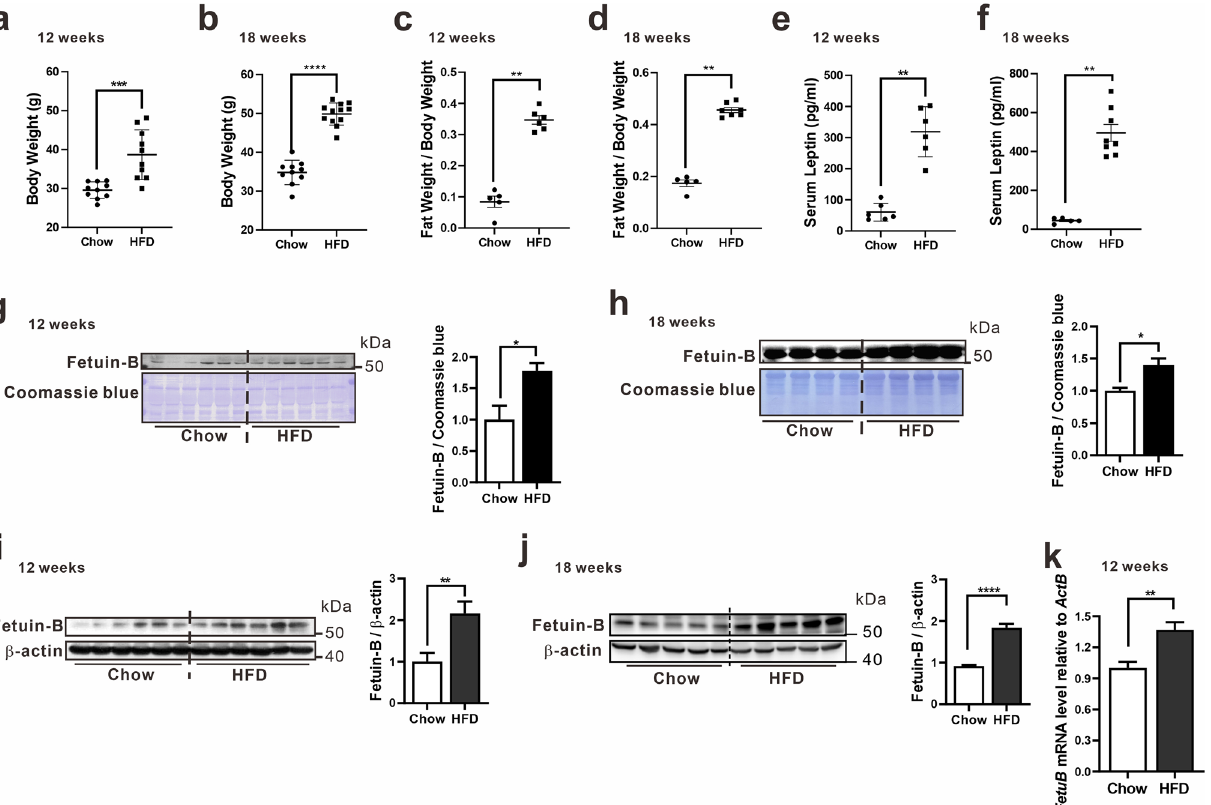
Figure 2. Expression of Fetuin B in HFD-induced obese mice. Body weight ( a , b ), body fat % ( c , d ), and serum leptin levels ( e , f ) were compared in mice fed chow with mice fed a HFD for 12 and 18 weeks (n =